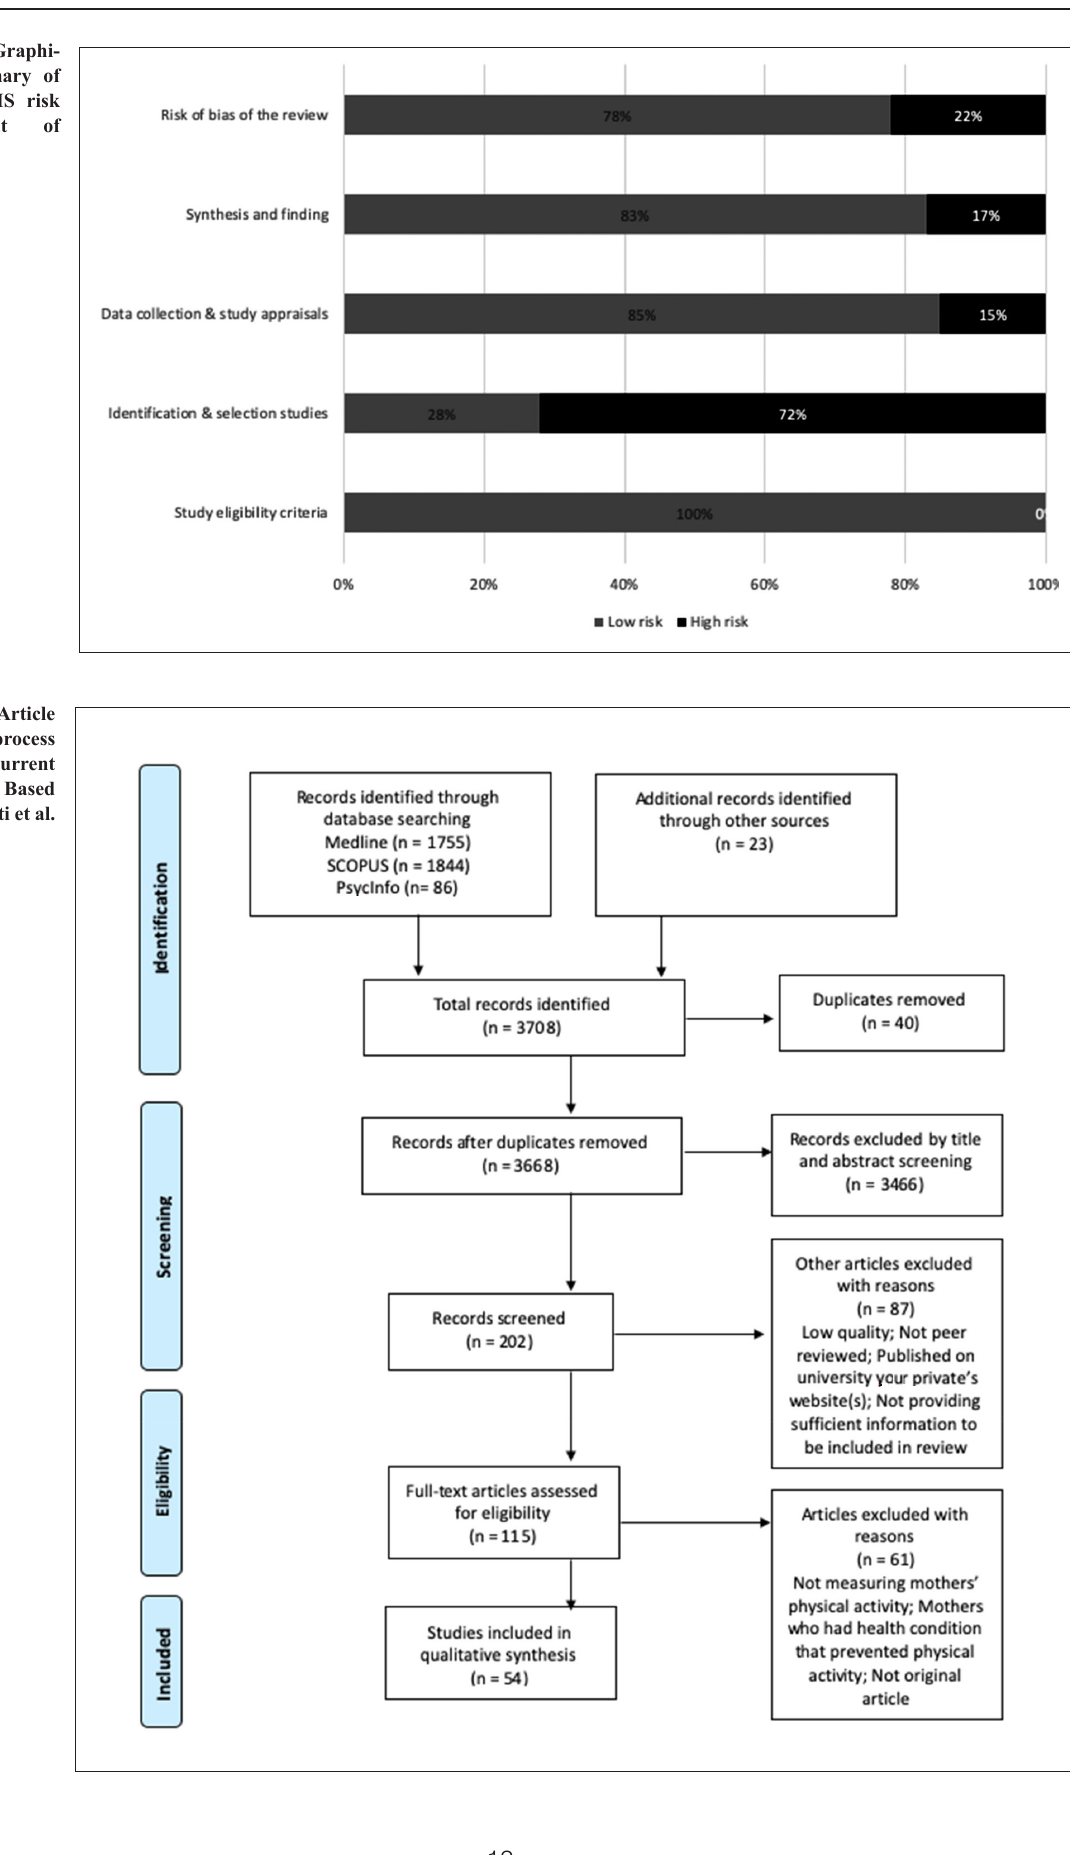
Figure 1. Graphi- cal summary of the ROBIS risk